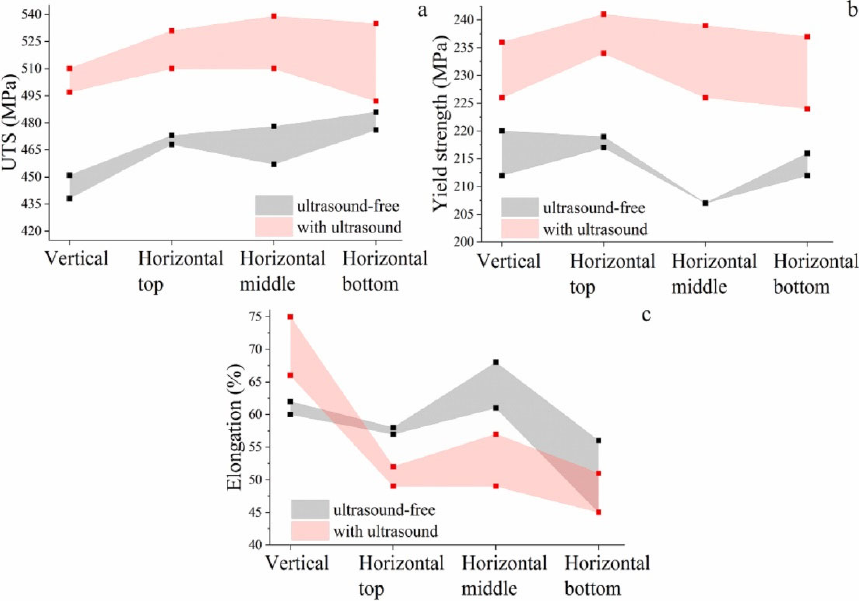
Figure 8. Ranges of the mechanical properties in AM specimens depending on their position in the billet: ( a ) the ultimate tensile strength, ( b ) the yield strength, ( c ) relative elongation of specimens before failure. These ranges show the scattering of the mechanical properties obtained for three dif ‐ ferent specimens cut in identical positions in the AM billets [97]. The red and gray shades correspond to the test results of samples obtained by the conventional EBAM method and with ultrasonic vibrations. The strength properties, such as UTS (ultimate tensile strength) and YS (yield strength), are higher for specimens ob ‐ tained by ultrasonic treatment. At the same time, the ultrasonic treatment decreased the ductility compared with the samples obtained by conventional EBAM.